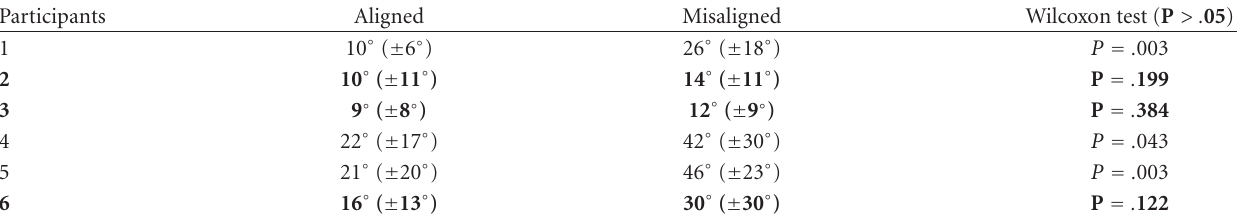
Table 2: Averages and standard deviations of AE (deg). The comparisons between aligned and misaligned direction estimations were performed by means of the Wilcoxon